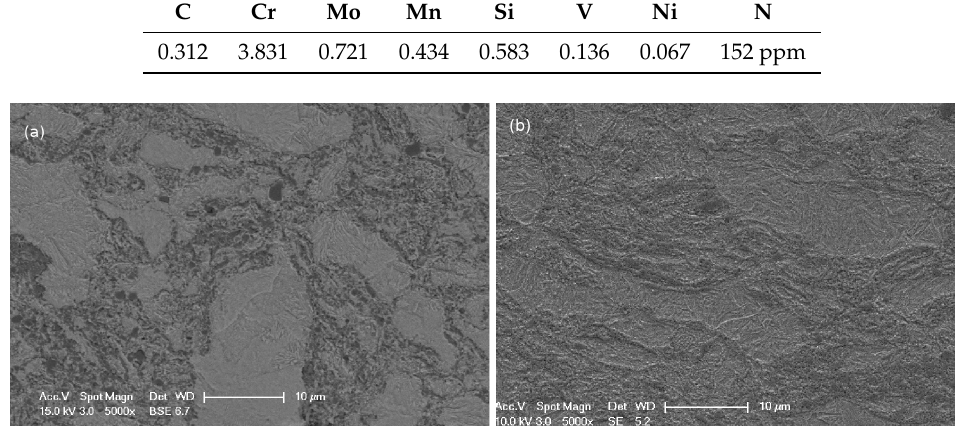
Figure 1b: the unreinforced areas composed of martensite and retained austenite (as we show later in the paper) and the reinforced areas where the matrix was mixed with TiC particles.